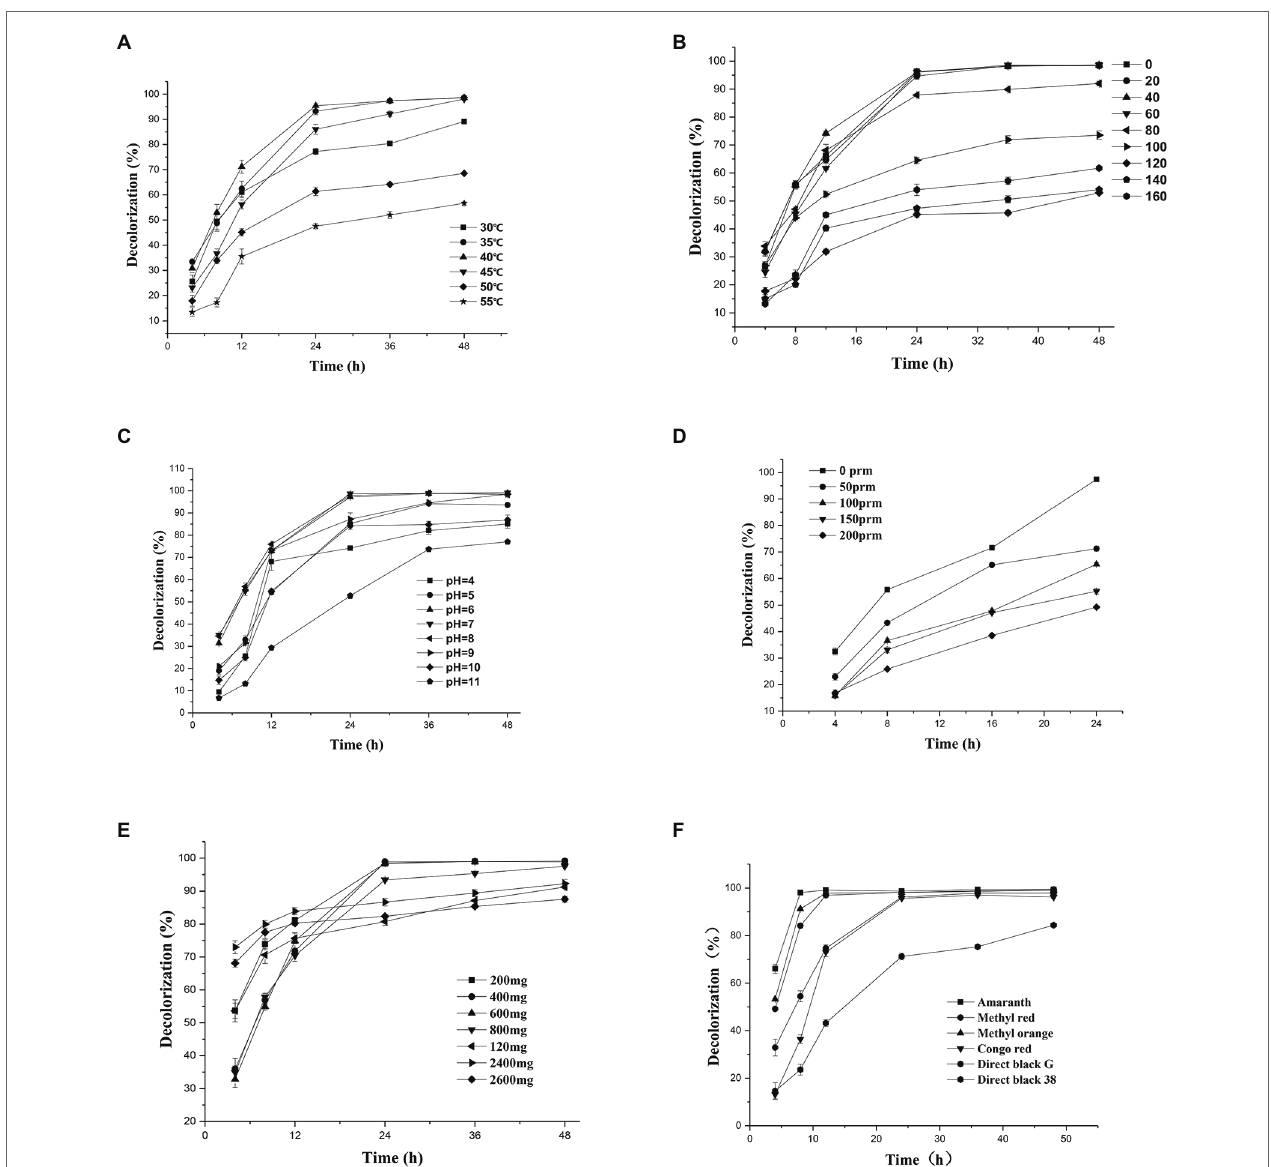
FIGURE 2 | Change in the decolorization efficiency of microflora under different incubation conditions: (A) temperature; (B) salt concentration; (C) initial pH; (D) shaker speed; (E) Direct Black G (DBG) concentration; and (F) different azo dyes. Data points represent the mean of three independent replicates. The standard error of the mean is indicated by error